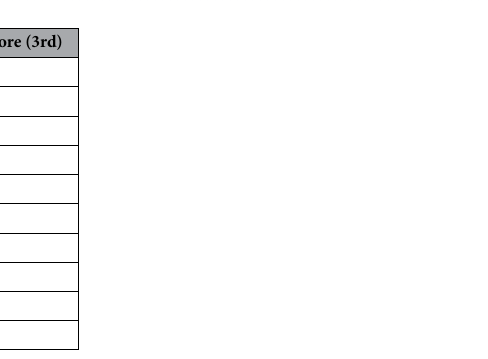
Table 2. F1 score on cell detection by participants who ranked top three in each